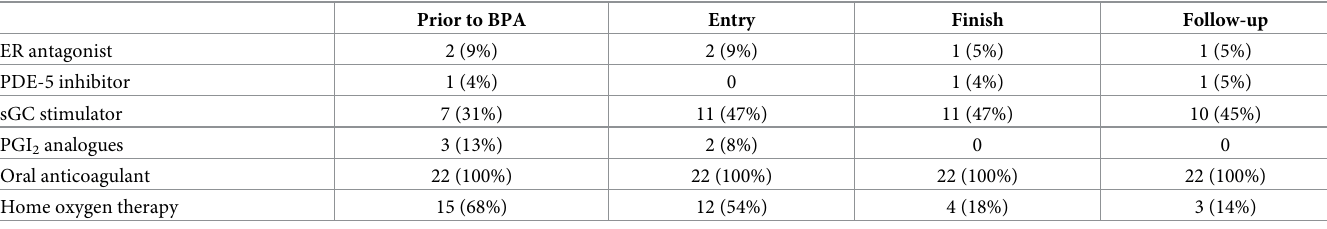
Table 2. Changes of medical treatment data.